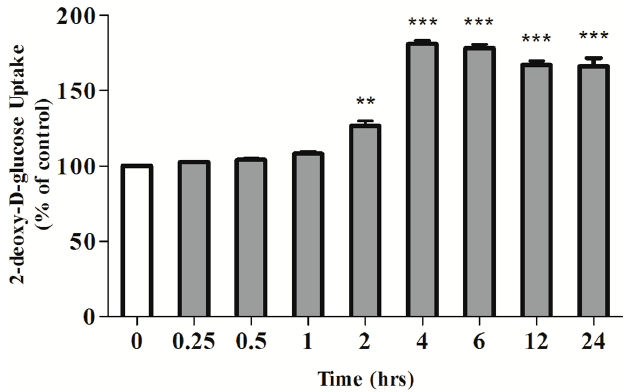
Figure 2. Effects of rosmarinic acid (RA) on glucose uptake (Time-course). Serum-deprived L6 myotubes were incubated without or with 5 µM RA for the indicated time. Data are expressed as percentage of control. Results are the mean ± SE of 3–5 independent experiments. ** p < 0.01, *** p < 0.001, vs control.